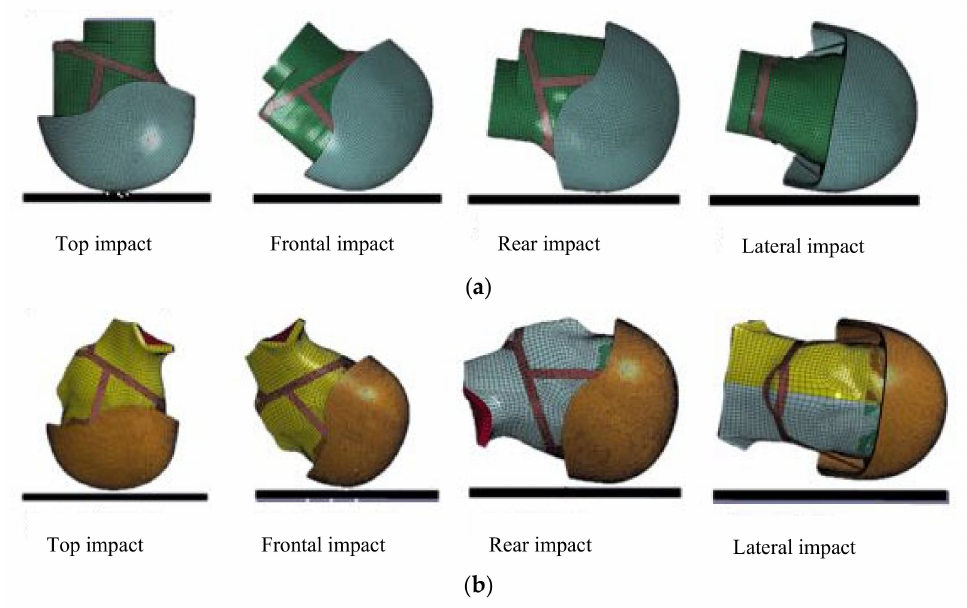
Figure 8. The di ff erent configurations for the head models: ( a ) Head surrogate; ( b ) Human